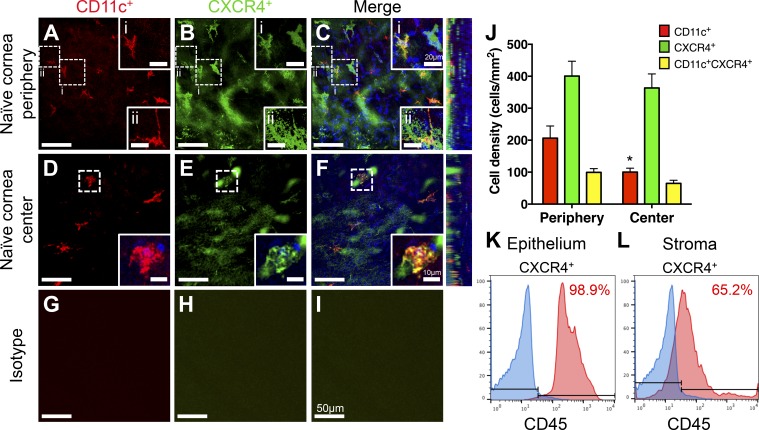
CXCR4 chemokine receptor is constitutively expressed in the naïve murine cornea. Representative confocal micrographs of naïve BALB/c corneas in peripheral (A–C) and central (D–F) stroma show expression of CD11c+ (red, A, D) and CXCR4+ (green, B, E) and colocalization (yellow, C, F) throughout the corneal stroma. Orthogonal views highlighting positive staining added to each corneal area. White dotted boxes show examples of CD11c+ DCs (magnified in A–C, stroma (i) and epithelium (ii); and D–F insets), as well as a CD11c− cells (magnified in A–C, inset i) coexpressing CXCR4 in the peripheral and central corneas. Isotype controls for CD11c and CXCR4 do not show positive staining (G–I). Cell density quantification for CD11c+ and CXCR4+ cells (cells/mm2) highlights populations of steady-state cDCs expressing CXCR4: significance for cell densities between central and peripheral cornea is denoted by an asterisk (J). Representative histograms of flow cytometry analysis of relative CXCR4 expression of CD45+ leukocytes in the inflamed corneal epithelium (K) and stroma (L). Data are shown as mean ± SEM. t-test, *P < 0.05. Scale bars denote 50 μm (A–I), 20 μm (A–C, insets i and ii), and 10 μm (D–F insets). n = 4.